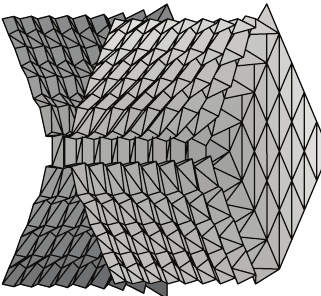
Figure 4: Variational iteration method for (cid:3) 3.14 (cid:4)